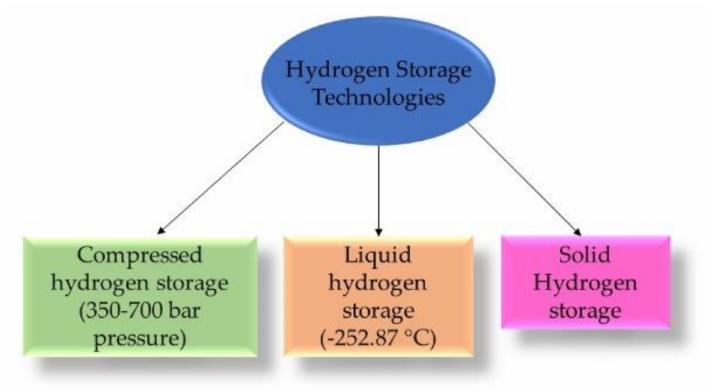
Figure 5. Hydrogen storage in the period from 1980 to 2018. Adapted from Singla et al.